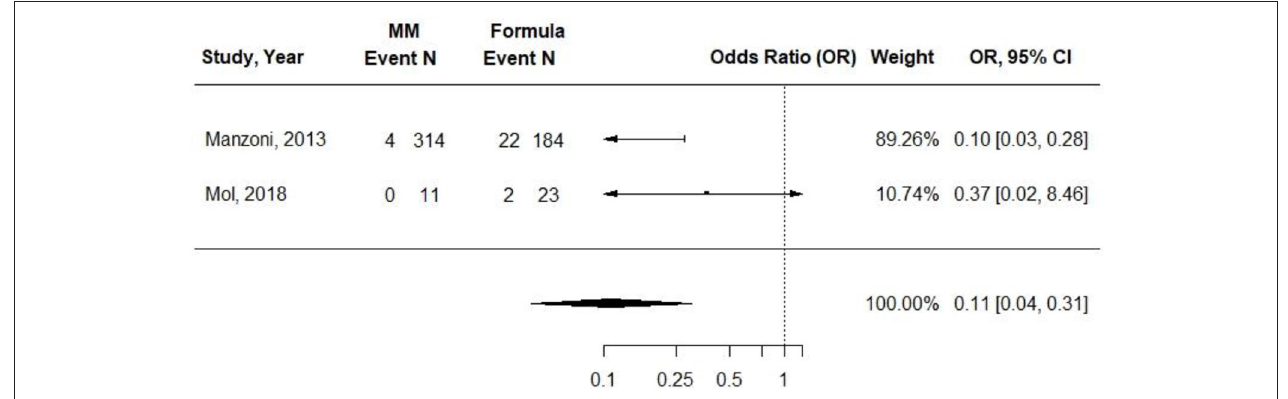
FIGURE 4 | Forest plot demonstrating OR (95%CI) of ROP for VLBW preterm infants receiving ≥ 75% intake from Maternal Milk (MM) compared to exclusive formula intake. log k ( p < 0.05) than those receiving corn infant formula at 36, but not at 57 weeks. There were no differences in cone